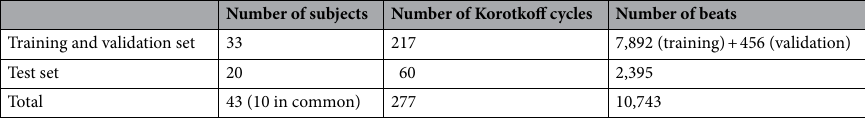
Table 1. Number of subjects, Korotkoff cycles, and beats.